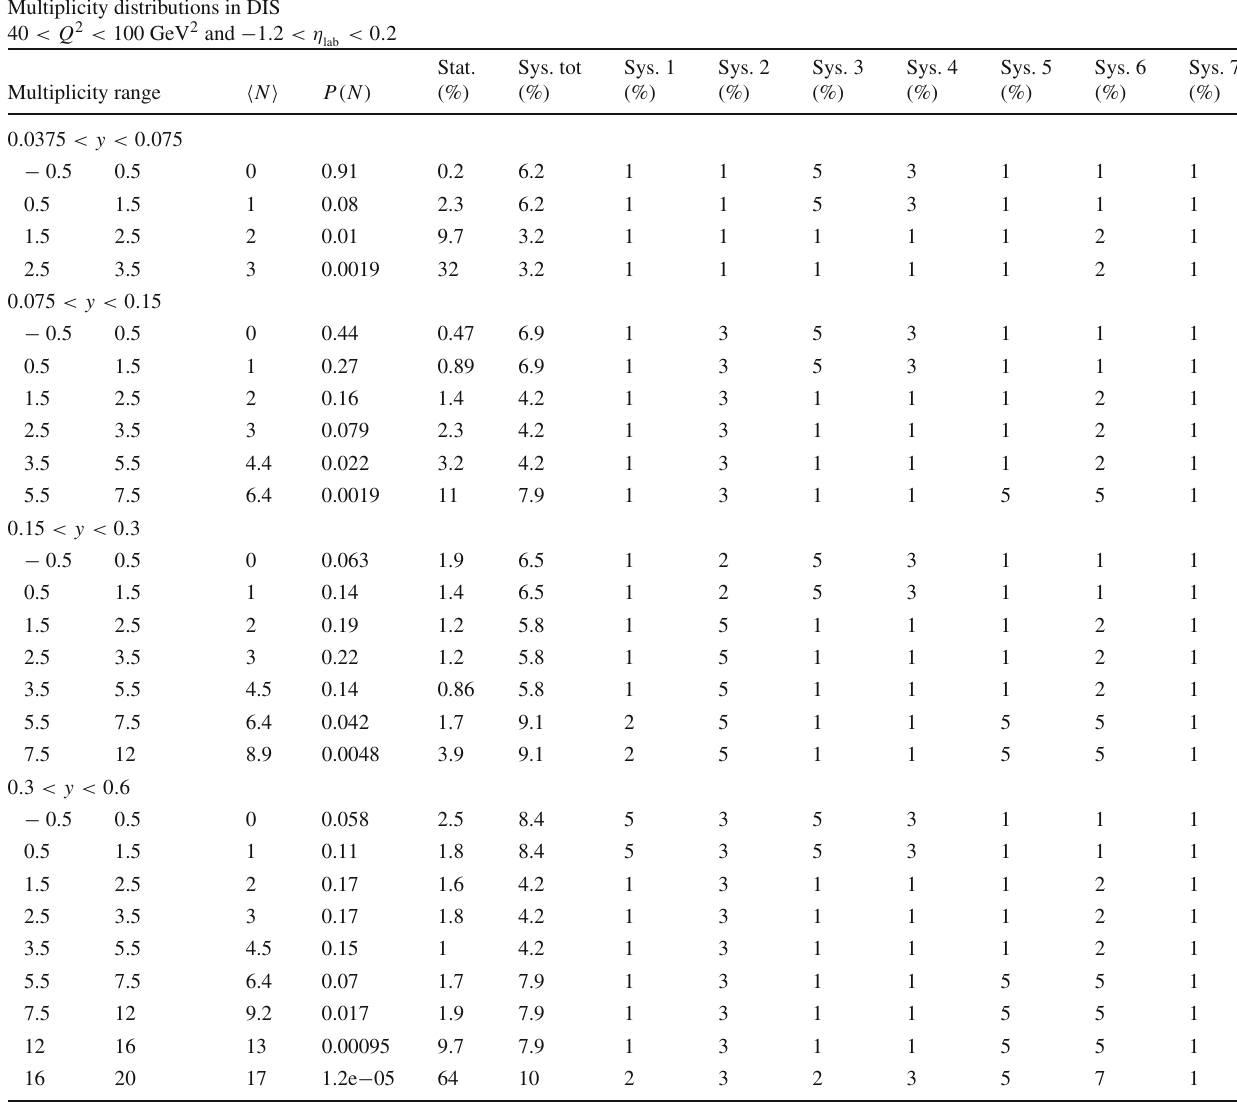
< 0 . 2, presented in four ranges of inelasticity y as indi- − 1 . 2 < η lab cated. The phase-space is further restricted as shown in Table 1